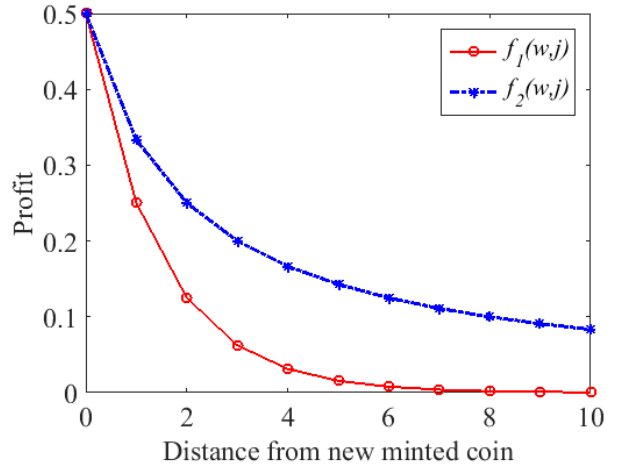
Figure 5. Profit-sharing sample